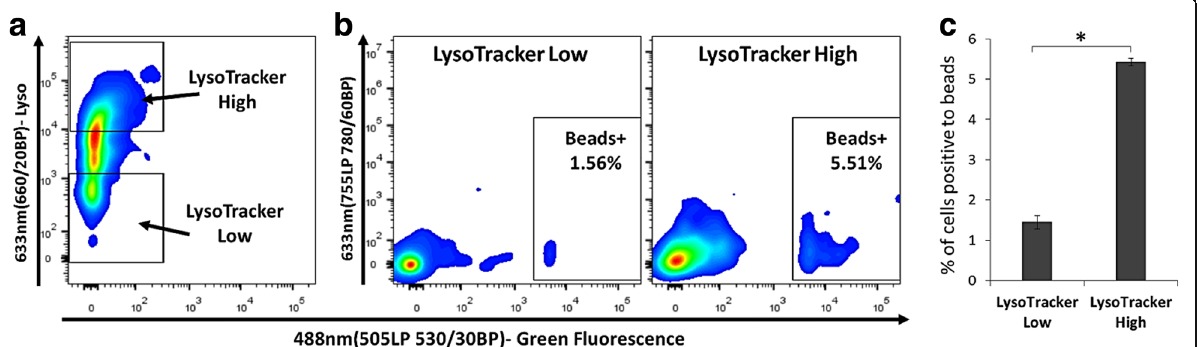
Fig. 6 Downstream process validation using a phagocytosis assay. a A. pallida cells were labeled with LysoTracker Deep Red and sorted to LysoTracker high and low expression. b – c The sorted cells were co-incubated overnight with green fluorescent beads for analysis of phagocytosis. b Example of the bead positive cells gated in the LysoTracker low (left panel) and high (right panel) populations. c Analysis of bead positive cells of three replicates of the sorted populations. The bead positive cells are approximately three - fold higher in the LysoTracker high population. ANOVA P * <